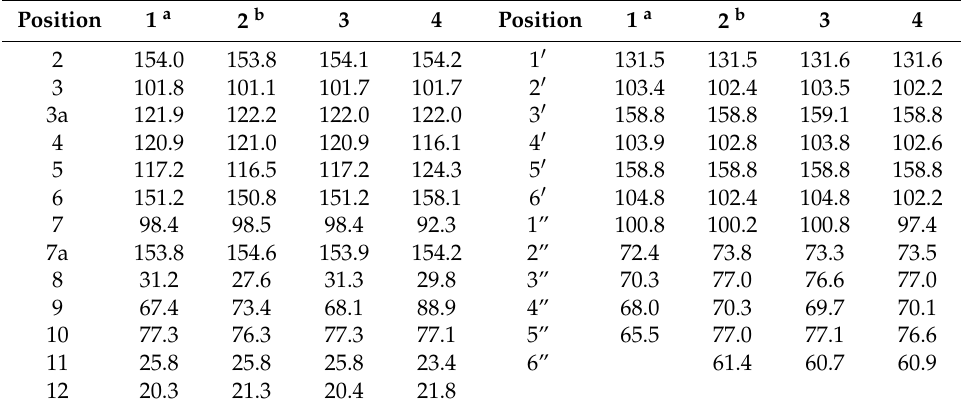
Table 2. 13 C-NMR spectroscopic data of compounds 1–4 in DMSO- d 6